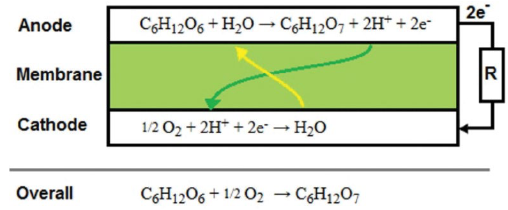
Fig. 1. T he most common reaction studied for glucose biofuel cells is the oxidation of glucose to gluconolactone and the reduc- tion of oxygen to water. According to Ref.